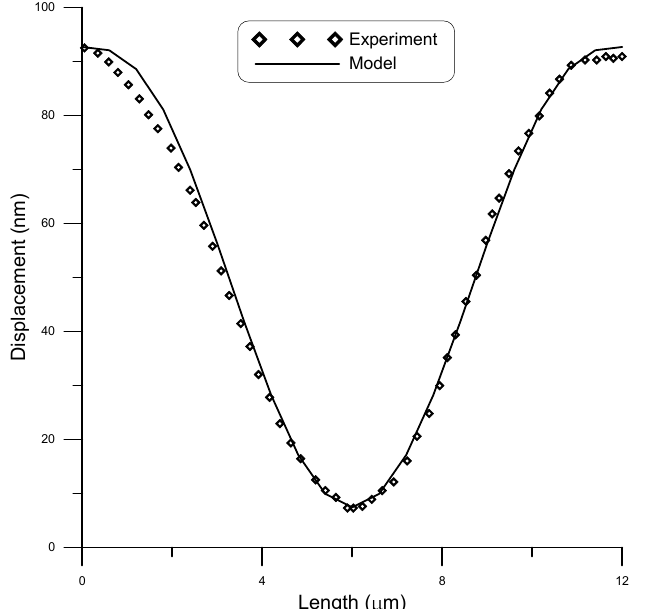
Figure 8. Displacement of a 12 µ m long beam of 190 nm diameter under point load of 134 nN, compared to experimental data